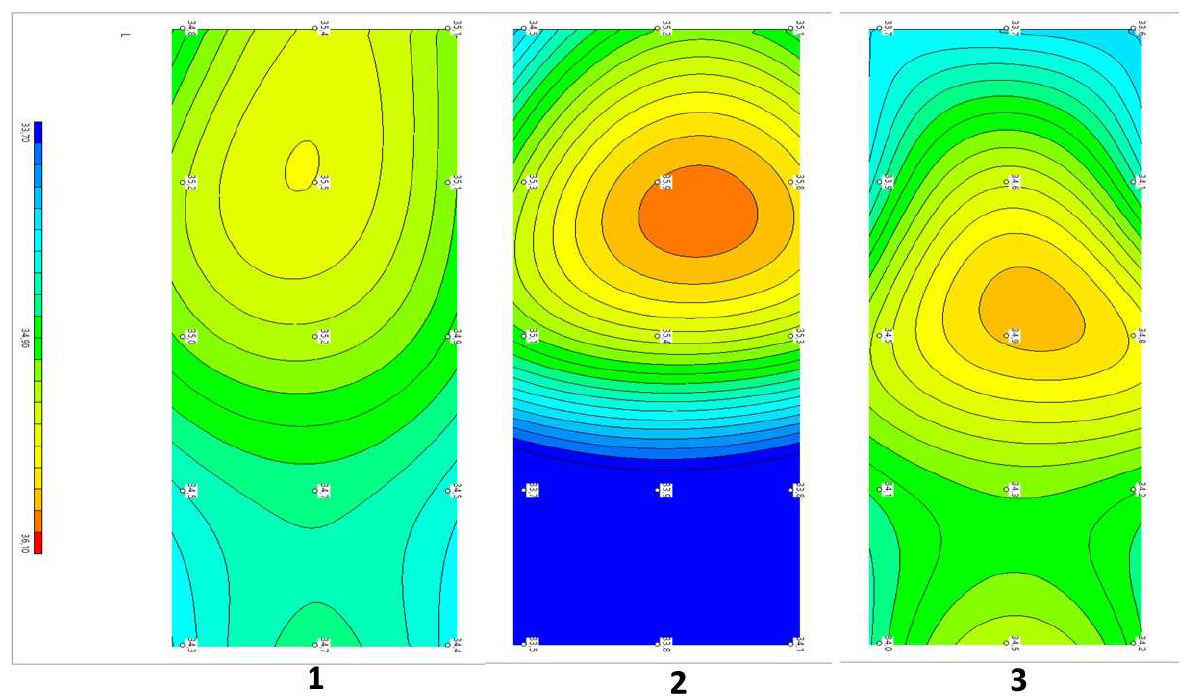
Figure 6. Dynamics of temperature fields in the lumbar region in patient In against the background of complex treatment. ( 1 ) Healthy volunteers, mean data, n = 31. ( 2 ) Patient Iin, before treatment. ( 3 ) Patient I.in, after treatment. Note: On the left, the field of internal temperatures, from left to right indicate L1 to L5 (in the center of the projection of the spinous processes; above and below, paravertebral 30 mm from the center); on the right, a thermogram of 15 measurement points. Compared with the symmetric temperature field of the control group (1) before treat- ment, patient (2) had visualized zones of increased temperature in the L2 projections above the spinous process and on the right, paravertebrally. The ΔТ= Tmax − Tmin depth temperature before treatment was 2.4 °C and that of the skin was 1.3 °C. After treatment (3), the asymmetry significantly decreased. There was a zone of slightly elevated temper- ature in projection L3 above the spinous process. The ΔТ = Tmax − Tmin internal temper- ature after treatment decreased and amounted to 1.0 °C, and −1.1 °C for the skin. This example shows that the decrease in pain from six to two points, in this patient with complex treatment, correlated with a decrease in Tmax and Tmin; the asymmetry of the fields decreased, and the temperature normalized with a decrease in the ΔТ of the depth and skin temperatures. 6. Discussion TENS has long been used for various pain syndromes. Currently, the mechanism of the analgesic efficacy of various devices and techniques is mainly associated with the ef- fects of neuropeptides and other regulatory peptides [10]. Unlike other applied TENS, SCENAR stimulates C-fibers, which most actively respond to electrical stimulation. Thus, SCENAR therapy can reliably reduce the severity of neck pain according to the VAS and the neck disability index (NDI) in comparison with the TENS group. SCENAR therapy is superior to TENS therapy in terms of analgesic effects and NDI for whiplash injuries [11]. Some TENS problems remain unresolved, such as the feeling of extinction of the en- ergy of stimulation in the patient due to the development of tolerance, which leads to the need for increasing the strength of the impact. The other problem is the static treatment of certain areas of the skin with various sticky and metal electrodes, which significantly re- duces the effectiveness of the treatment.